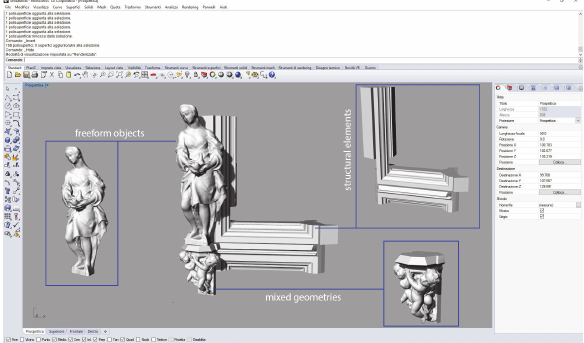
Figure 6. Three types of geometry: 1. Free form coming from re-topology operation, 2. Extrusion of surface along line, 3. Mixed